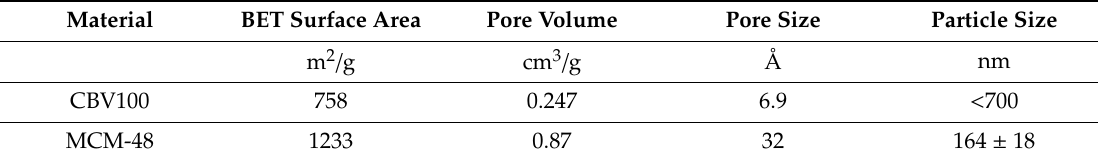
Table 1. Main properties of the commercial NaY type zeolite (CBV100) and mesoporous silica (MCM-48) used in this work.